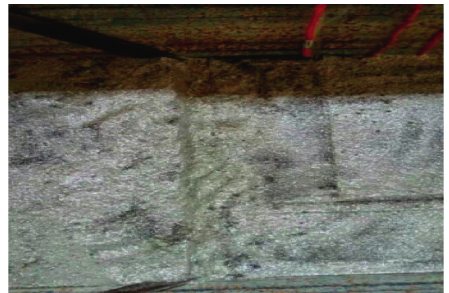
Figure 4: Layout of the fault zone.